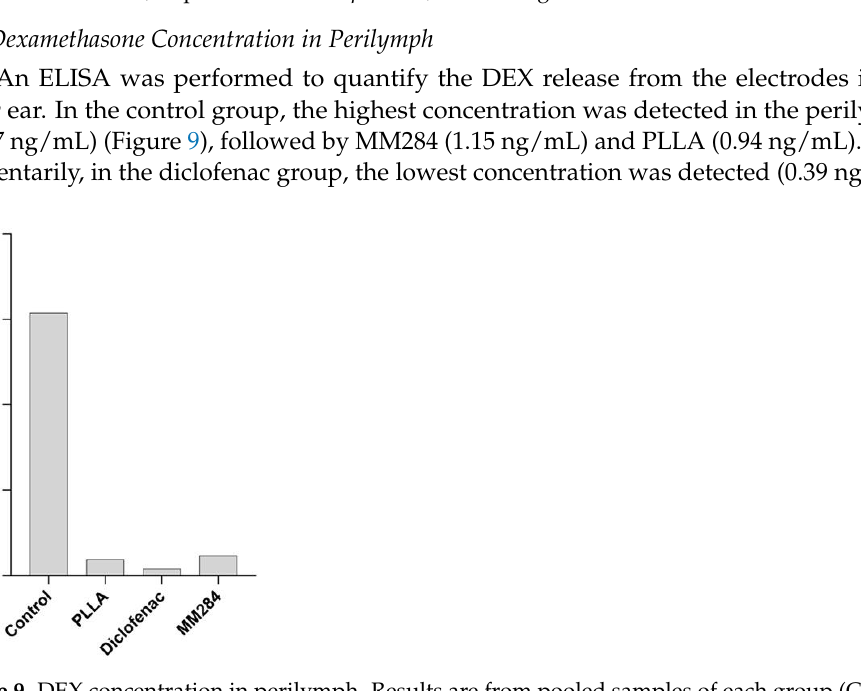
Figure 8. Spiral ganglion neuron density: ( A ) control group, no significant differences; ( B ) PLLA group, significant differences in all turns of the cochlea except the first middle turn; ( C ) diclofenac group, significant differences in all turns of the cochlea except the fourth middle turn; ( D ) MM284 group, no significant differences. Mean ± SD. Light gray dotted bars = right, untreated side; black checkered bars = left, implanted side. * = p < 0.05; ns — not significant.